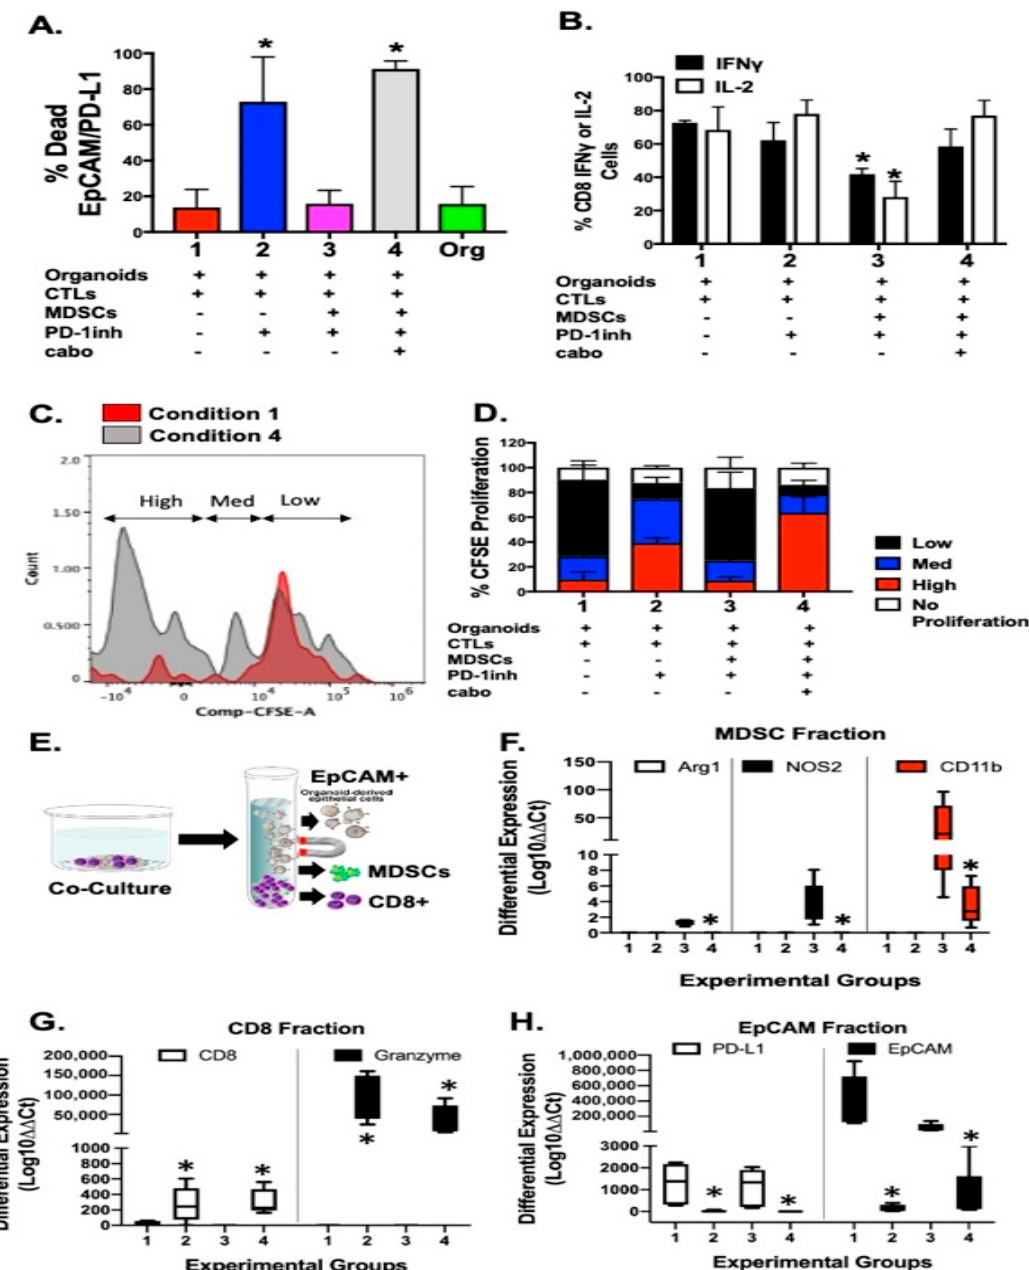
Figure 4. Analysis of murine-derived autologous pancreatic cancer organoid / immune cell co-cultures. Flow cytometric analysis quantifying the percentage of ( A ) zombie-positive (dead) EpCAM + PD-L1 + tumor, and ( B ) CD8 + IFN γ + and CD8 + IL-2 + cells in co-cultures. ( C , D ) CTL proliferation as measured by CFSE T cell proliferation assay. ( E ) Co-cultures were fractionated into EpCAM + , MDSC + , and CD8 + cell populations by magnetic separation. Quantitative RT-PCR was performed using RNA extracted from ( F ) MDSC, (G) CD8, and ( H ) EpCAM fractions. * p < 0.05; n = 4 individual co-cultures per group.